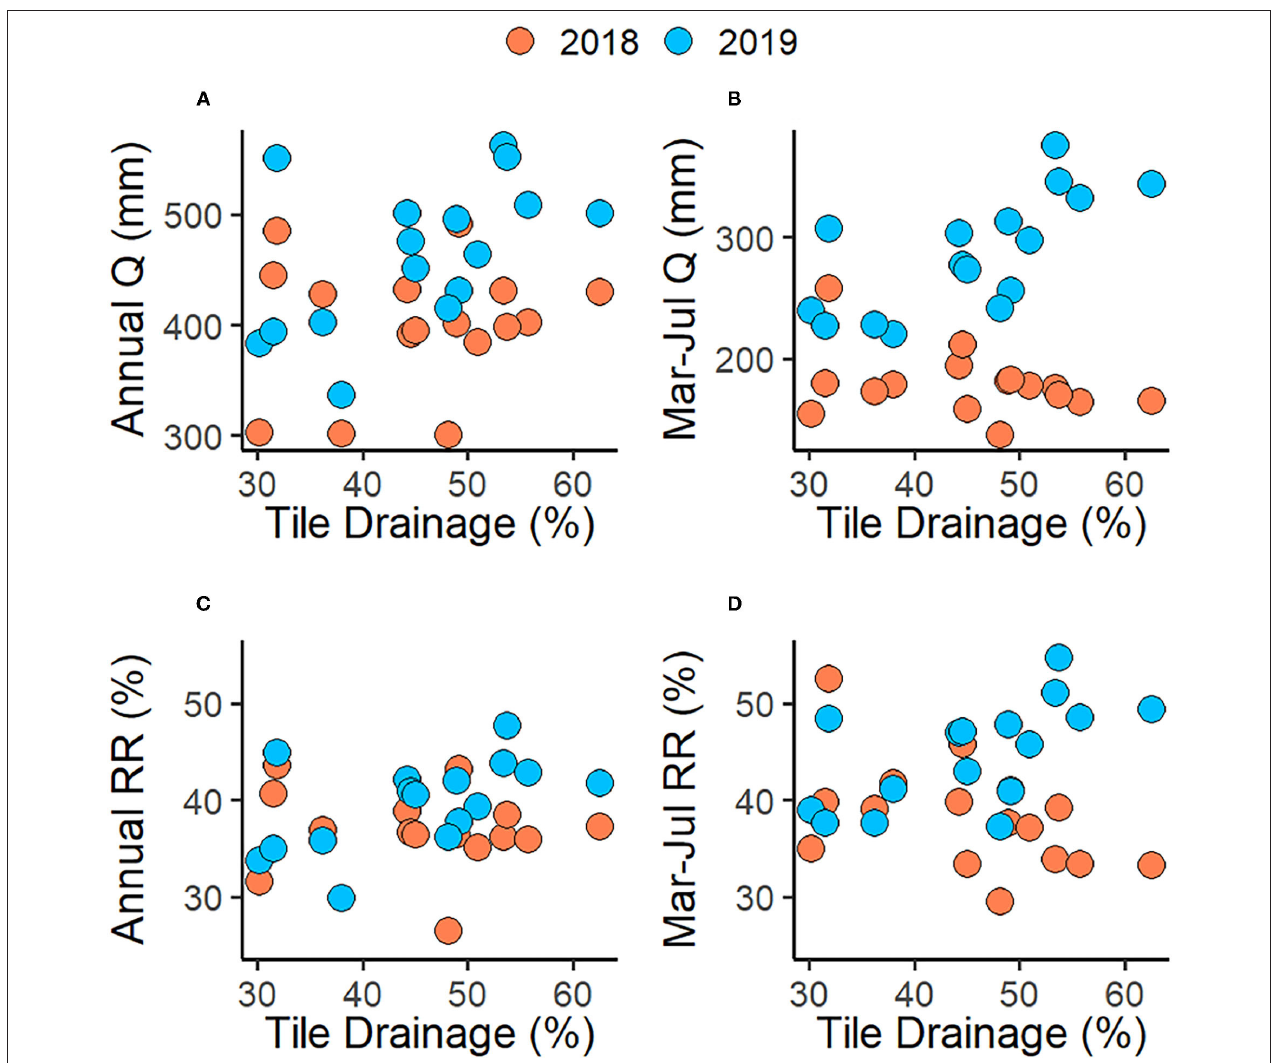
FIGURE 3 | Annual ( A ; Pearson’s r = 0.11 and 0.52, respectively) and March–July ( B ; Pearson’s r = − 0.33 and 0.70, respectively) runoff (Q) vs. tile drainage during 2018 and 2019. Annual ( C ; Pearson’s r = − 0.04 and 0.53, respectively) and March–July ( D ; Pearson’s r = − 0.49 and 0.70, respectively) runoff ratio (RR) vs. tile drainage for 2018 and 2019.